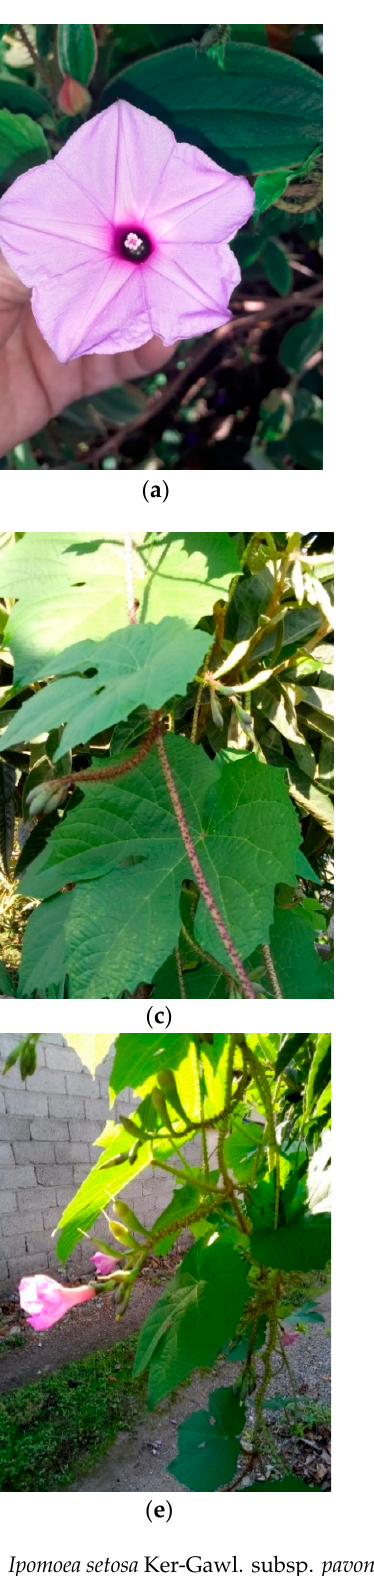
Calabria (Reggio Calabria province) (Photograph CM Musarella).